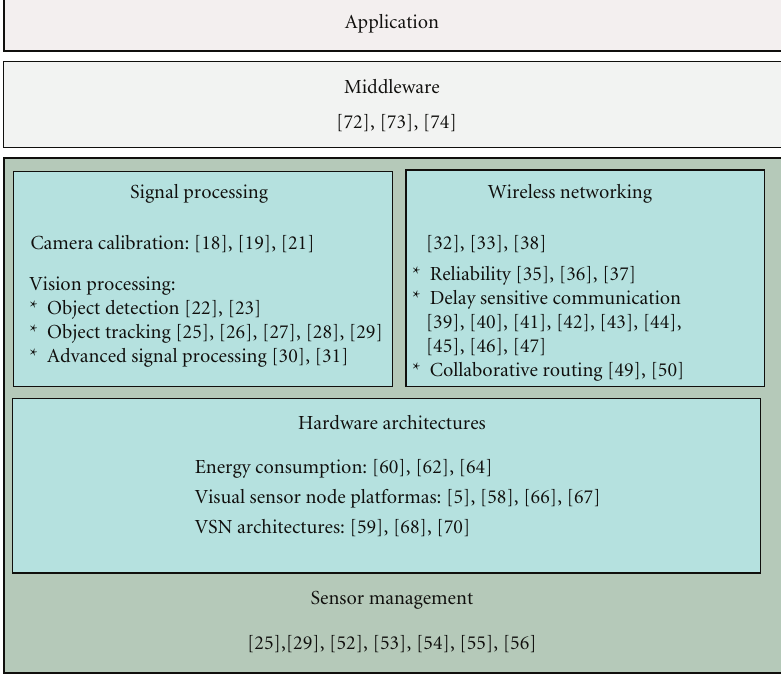
Figure 1: Several research areas that contribute to the development of visual sensor networks.